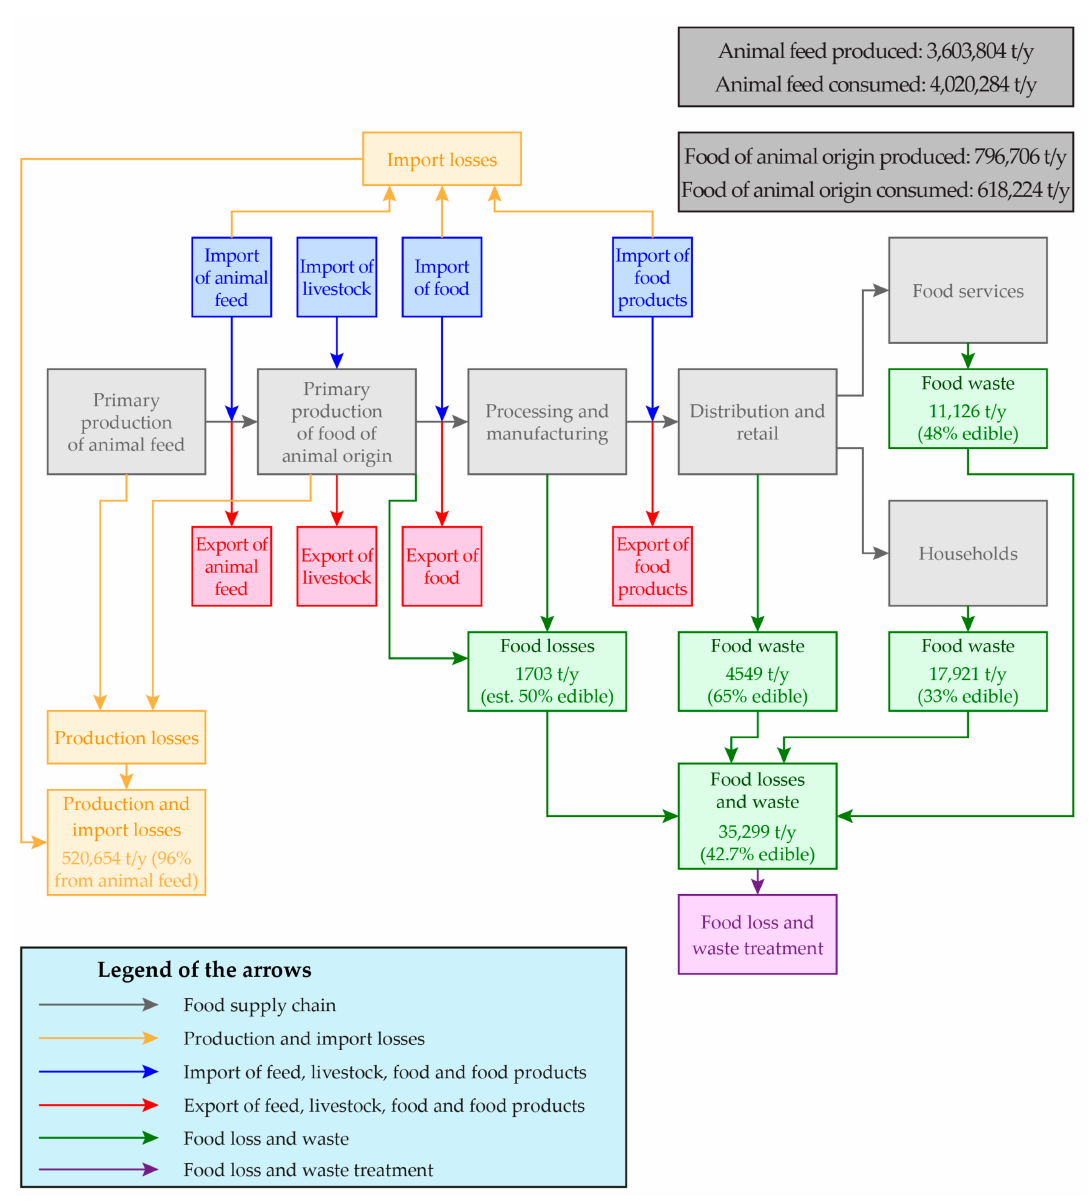
Figure 4. The supply chain for food of animal origin